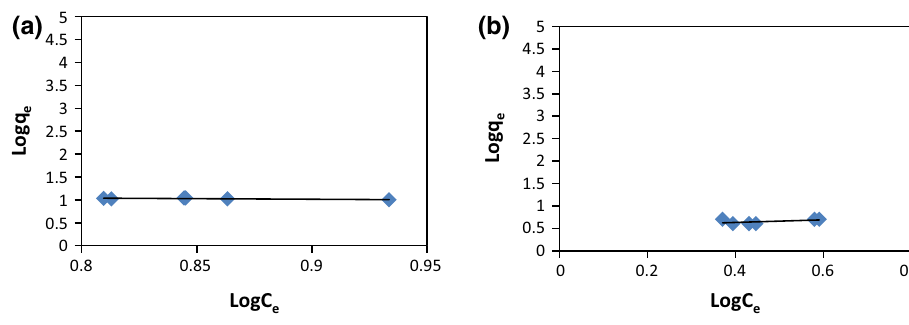
Fig. 8 Freundlich isotherm plot on a aniline and b phenol removal by